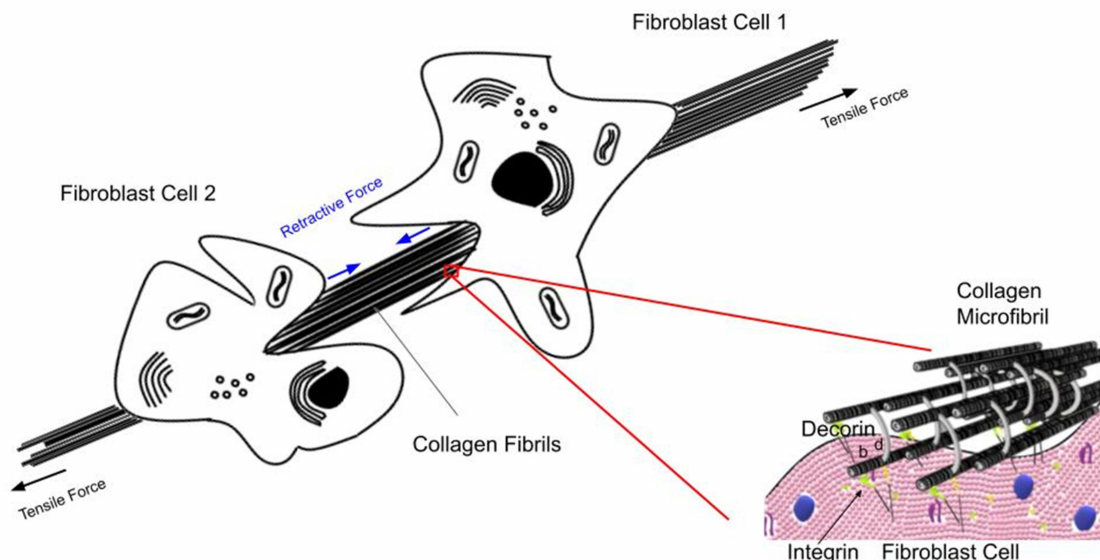
Figure 9. Diagram illustrating the tensile forces acting on collagen fibers and cells acting in the skin. Collagen fibers are stretched in tension under normal physiological conditions. This causes the fibroblasts attached to the collagen fibers to generate a retractive force via attachment through integrin and decorin molecules. These attachments serve as a feed-back mechanism to skin cells reflecting the current level of loading. Increased external loading stretches the collagen fibers as well as the attached cells up-regulating mechanotransduction under normal physiological conditions. This explains why weightlifting increases muscle size and also generates more skin to cover the larger muscles due to fibroblast loading via increases in skin tension. Note the role of integrin–collagen–fibroblast attachments as well as collagen–decorin attachments at the d and e